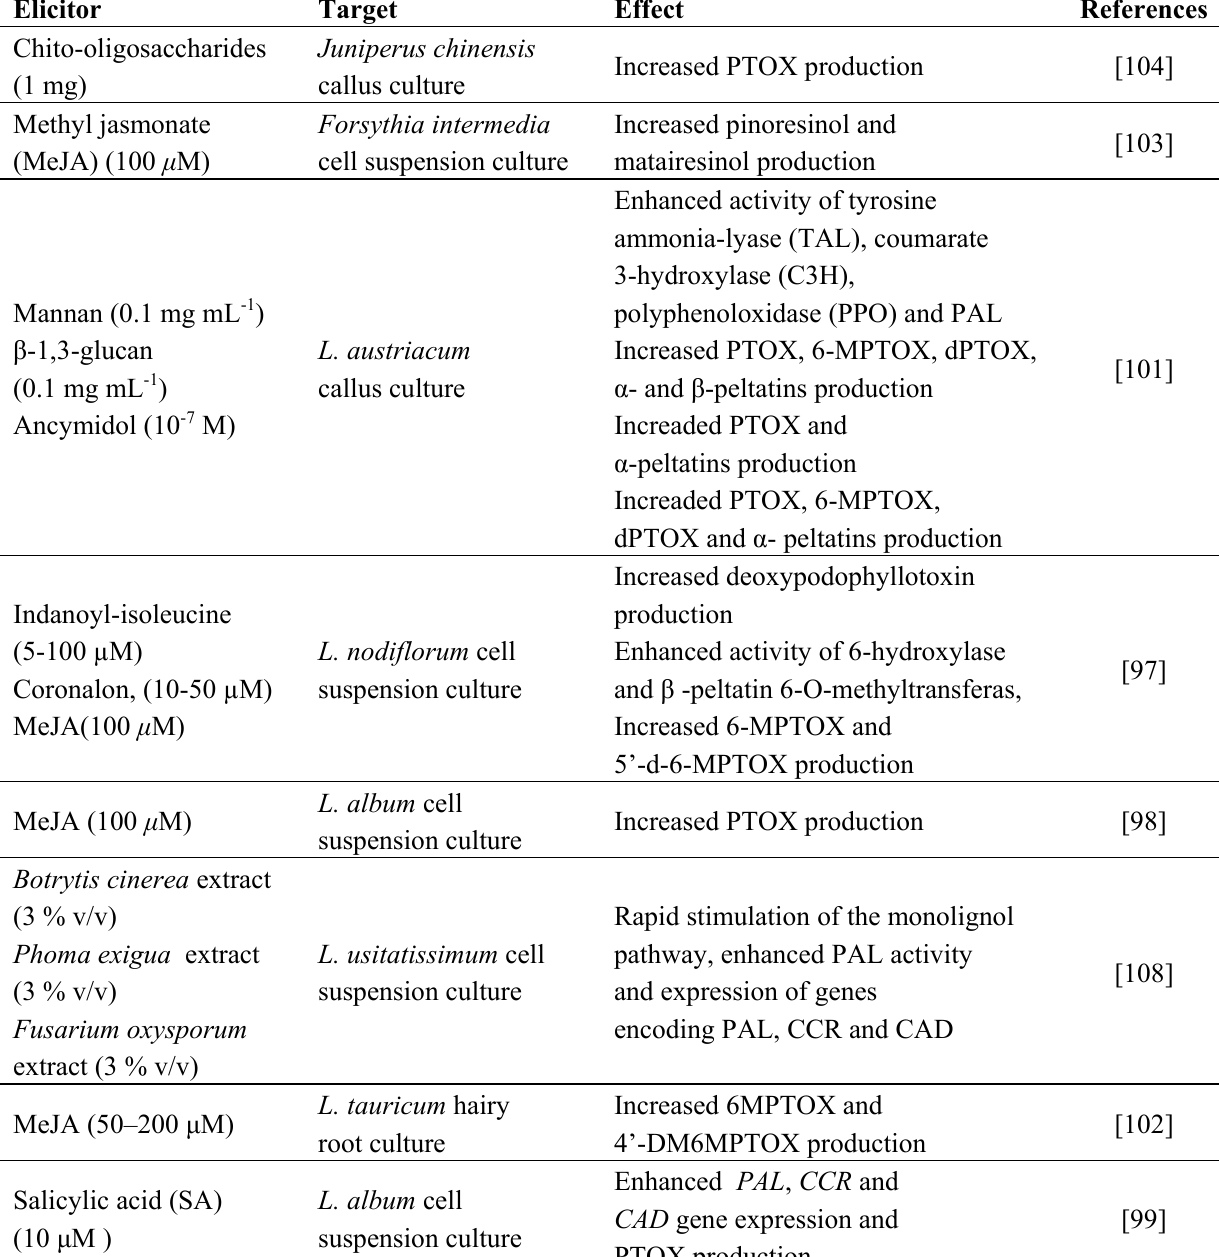
Table 1. List of Major Elicitors and Their Effects on Lignan